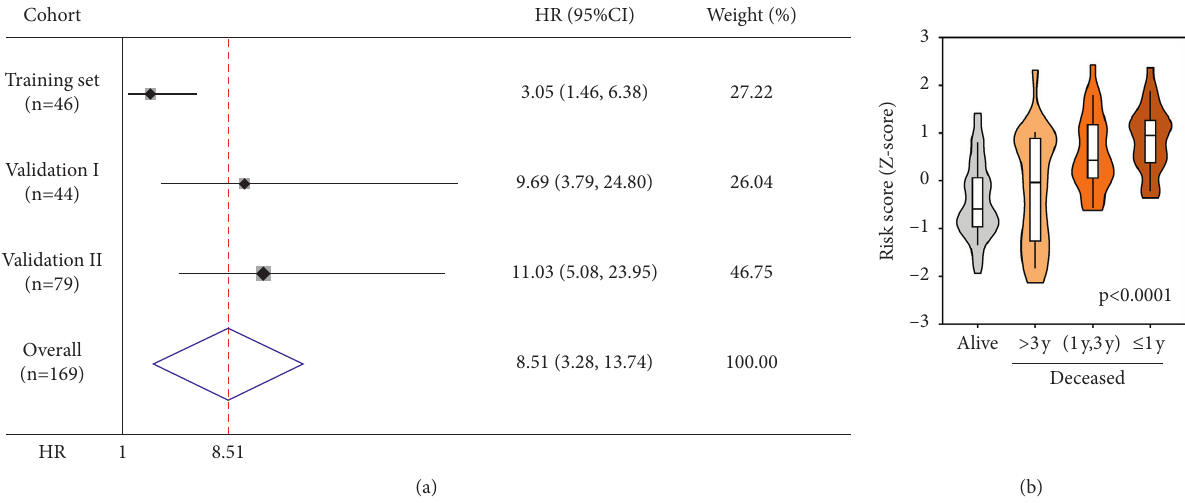
Figure 3: Gene signature-derived risk scores could discriminate high-risk patients in the pooled cohort: (a) meta-analysis indicated patients with higher risk scores exhibited worse overall survival with an integrated HR of 8.51 (95% CI � 3.28–13.74) and (b) Z-scores of risk score were significantly elevated in patients who died during follow-up, especially in shorter-term survival groups ( p < (Figure 6(b)). With a threshold of p < 0.05 using Fisher’s